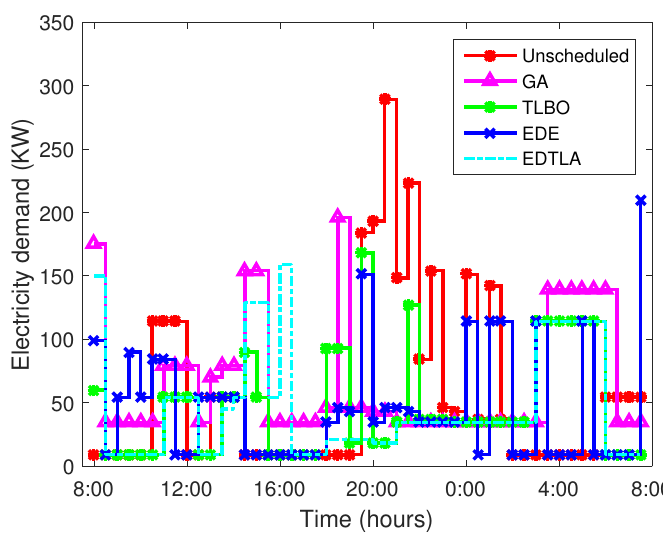
Figure 11. Hourly electricity demand. Teaching learning-based optimization (TLBO); enhanced differential evolution (EDE); and enhanced differential teaching learning algorithm